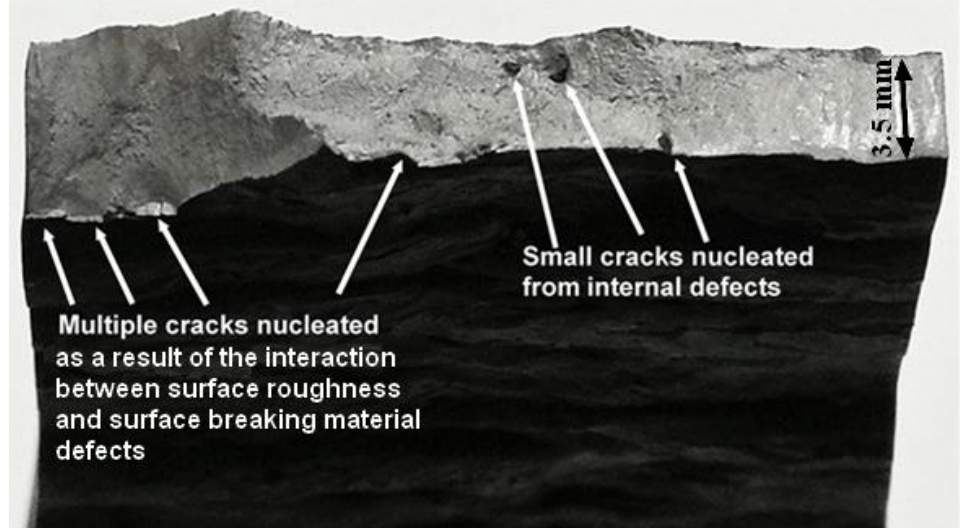
Figure 1. Picture of the failure surface of a WAAM 18Ni 250 Maraging steel test showing multiple cracks nucleating due to the interaction between surface roughness and surface-breaking material discontinuities, but little cracking associated with internal pores/voids.